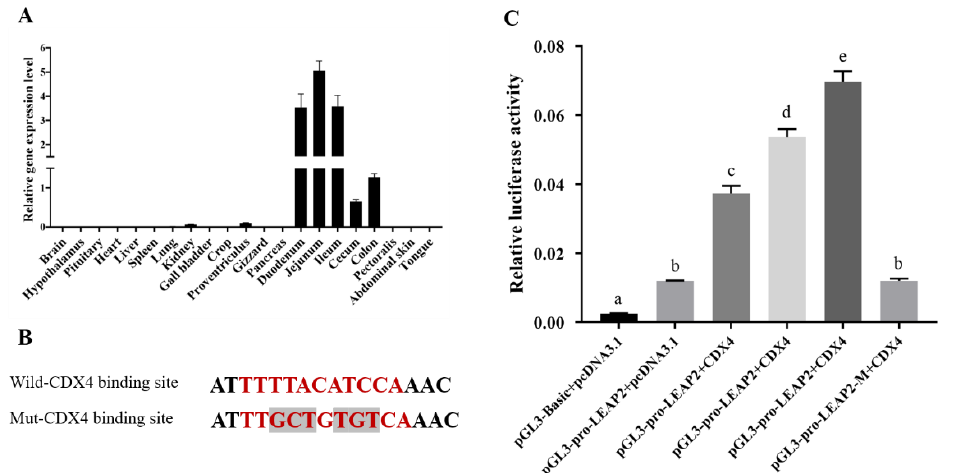
Figure 4. Dual luciferase assay of the 5 ′ flanking region of chicken LEAP2 gene. ( A ) chicken CDX4 gene expression profile; ( B ) the strategy to mutate the predicted CDX4 binding site—the red sequence is the predicted CDX4 binding sequence of LEAP2 and the mutated bases are in black; ( C ) dual luciferase assay of the promoter region of chicken LEAP2 —the concentration of the overexpression vector group was 1 µ g, 2 µ g, and 3 µ g, and the CDX4 overexpression of the mutated group was 1.5 µ g. Different lowercase letters in the bar indicate a significant difference among different groups ( p ≤ 0.05, n = 3). Abbreviation: CDX4, caudal type homeobox 4.